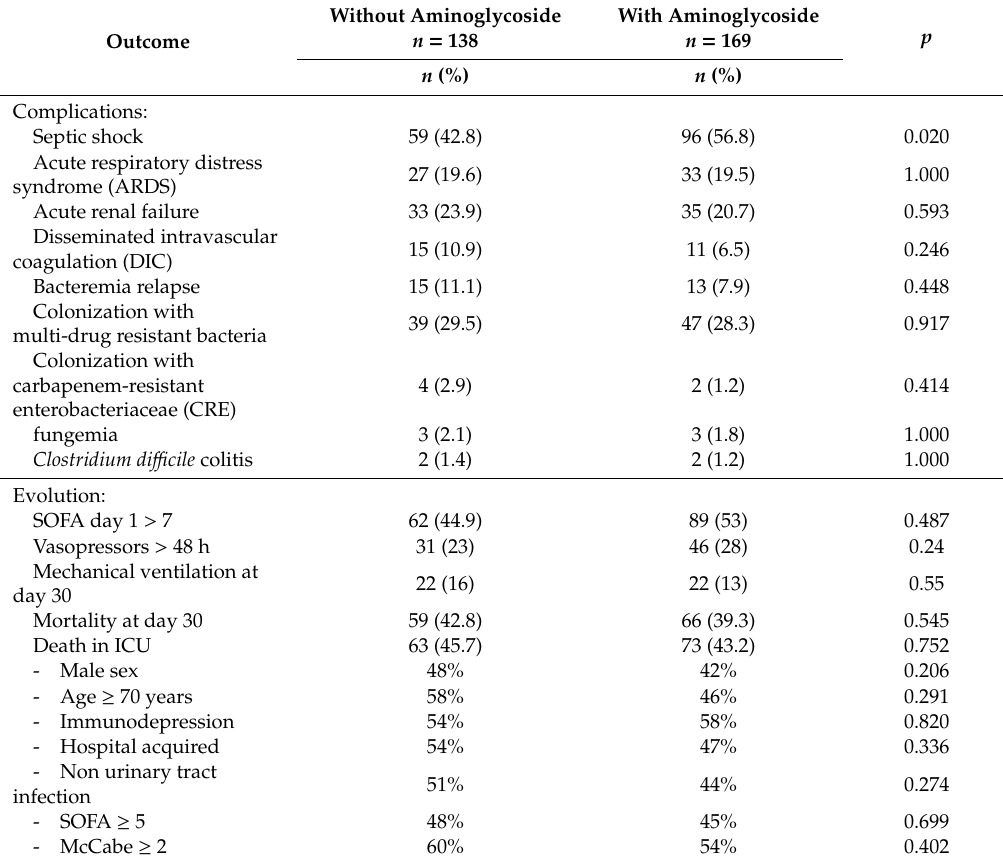
Table 3. Outcome according to empirical aminoglycoside